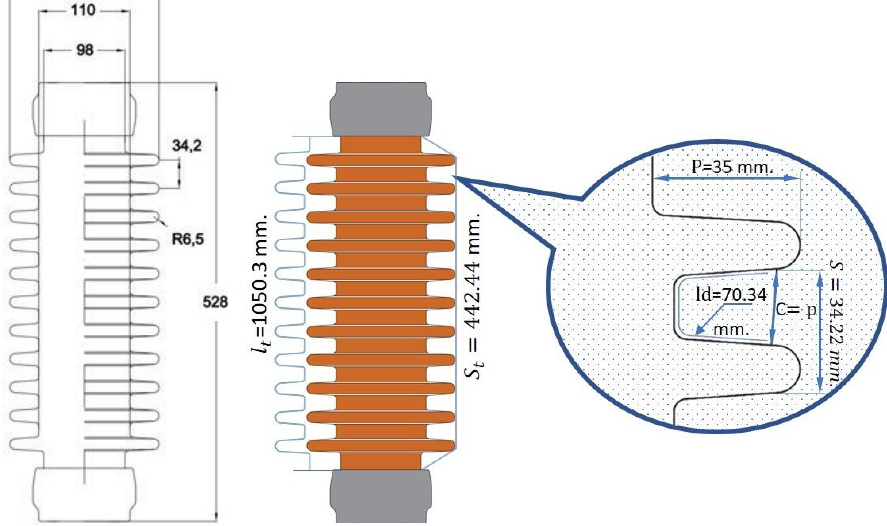
Figure 1. Railway electrification system: ( a ) Overview of railway electrification system; ( b ) Design of overhead line insulation equipment as porcelain insulator.